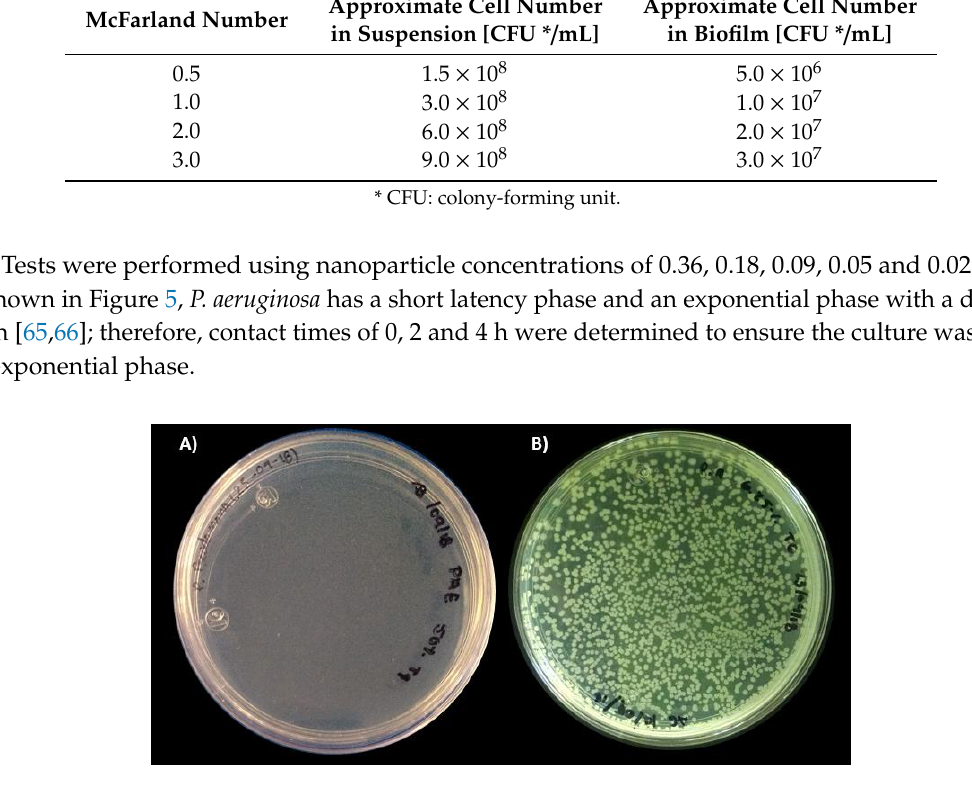
Figure 4. Detailed Spectra of the Ag3d region for the Ag nanoparticles synthesized with Geranium . Black points are experimental data and the red line is the fitting result. Table 1. Composition and cellular concentration according to the different turbidity patterns of the McFarland scale.